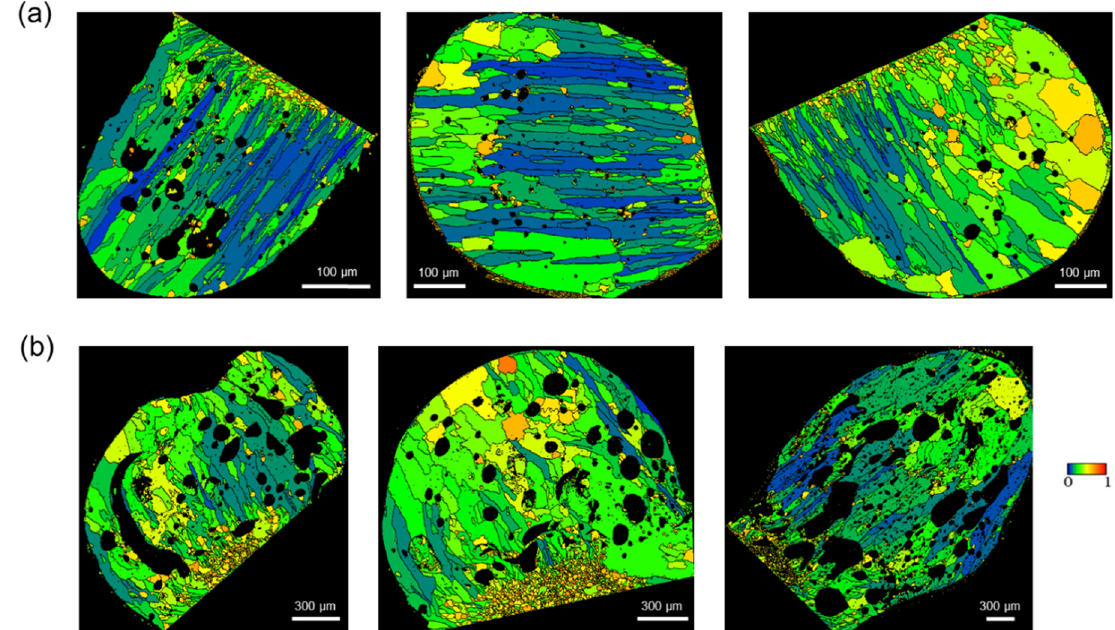
Figure 6. Grain aspect ratio maps: ( a ) PABs and ( b ) SABs.